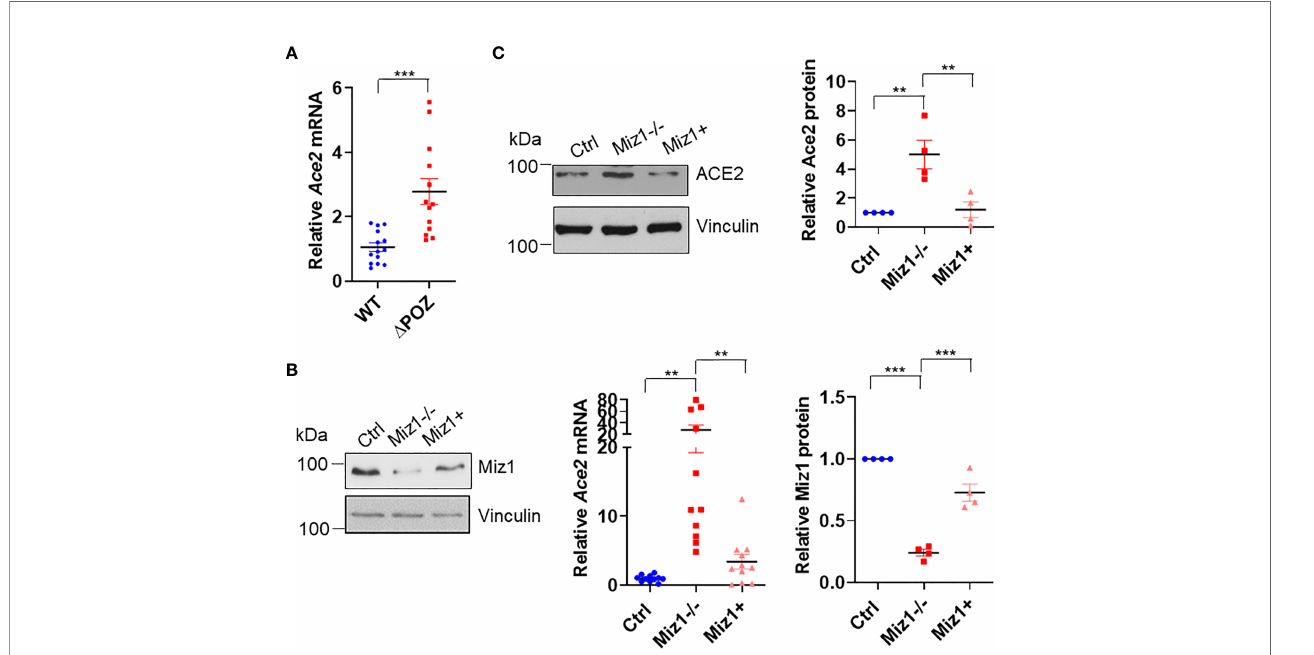
FIGURE 4 | Miz1 represses Ace2 transcription in mouse lung epithelial cells. (A) Ace2 mRNA expression in MLE-12/Miz1(WT) and MLE-12/Miz1( d POZ) cells as analyzed by RT-qPCR. (B, C) Ace2 mRNA (B) and protein expression (C) in the control KP cells (Ctrl), Miz1 KO KP cells (Miz1 − / − ) or Miz1 KO KP cells expressing exogenous Miz1 (Miz1+). Data are presented as means ± sem from three to four independent experiments. * p < 0.05, ** p < 0.01, *** p < 0.001 and **** p <